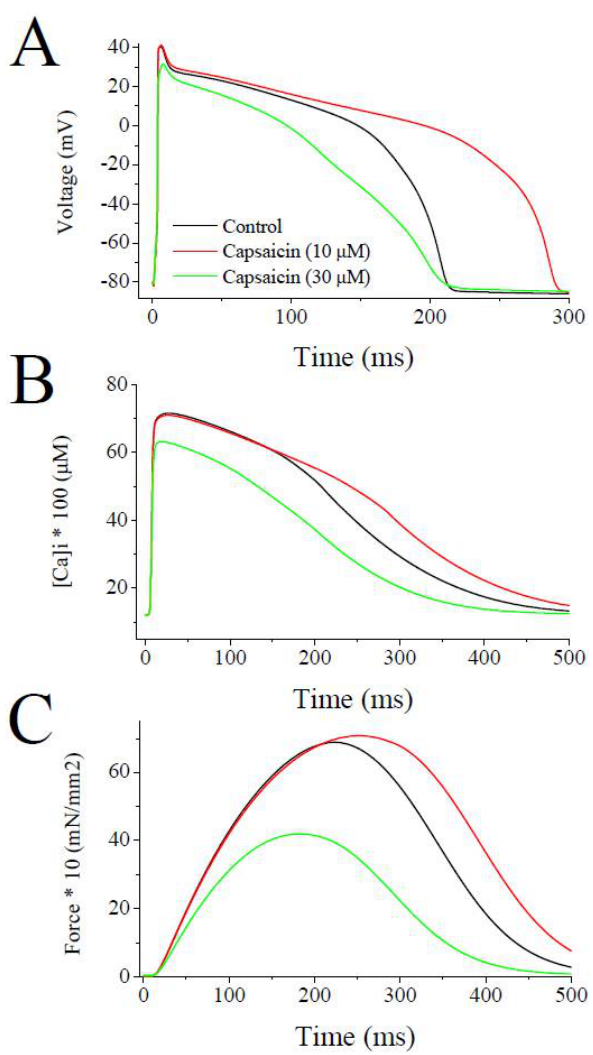
Figure 7. Effects of low and high concentrations of capsaicin on the simulated action potentials, intracellular Ca 2+ transients, and force development during a single twitch response using LabHEART simulations. ( A ) At 10 µM capsaicin concentrations, the inhibition of I Kr , I Ks , I to was incorporated. Whereas, at 30 µM capsaicin concentrations inhibitions of I Kr , I Ks , I to , I K1 , I Na , and I Ca-L were incorporated into the model. At 10 µM concentration, capsaicin induced marked prolongation (39%) of APD 50 , while at higher concentration (30 µM) significantly shortened (27%) the APD 50 . ( B ) Capsaicin, at the concentration of 10 µM, caused a slight delay in decay phase of Ca 2+ transient. At higher concentration of 30 µM, capsaicin induced a marked suppression of Ca 2+ transient. ( C ) Capsaicin, at 10 µM concentrations, caused a slight delay in decay phase of force development, but at higher concentrations of 30 µM, capsaicin induced a marked inhibition of force development during a simulated twitch response of a rabbit ventricular cardiomyocyte.